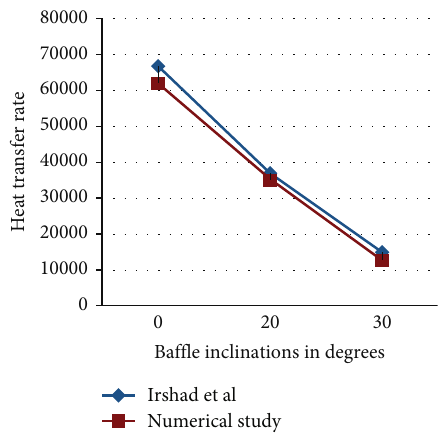
Figure 4: Validation plot of Irshad et al. with numerical study.